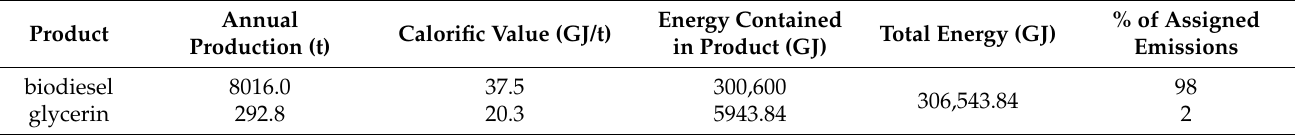
Table 14. Allocation of emissions based on the calorific value of